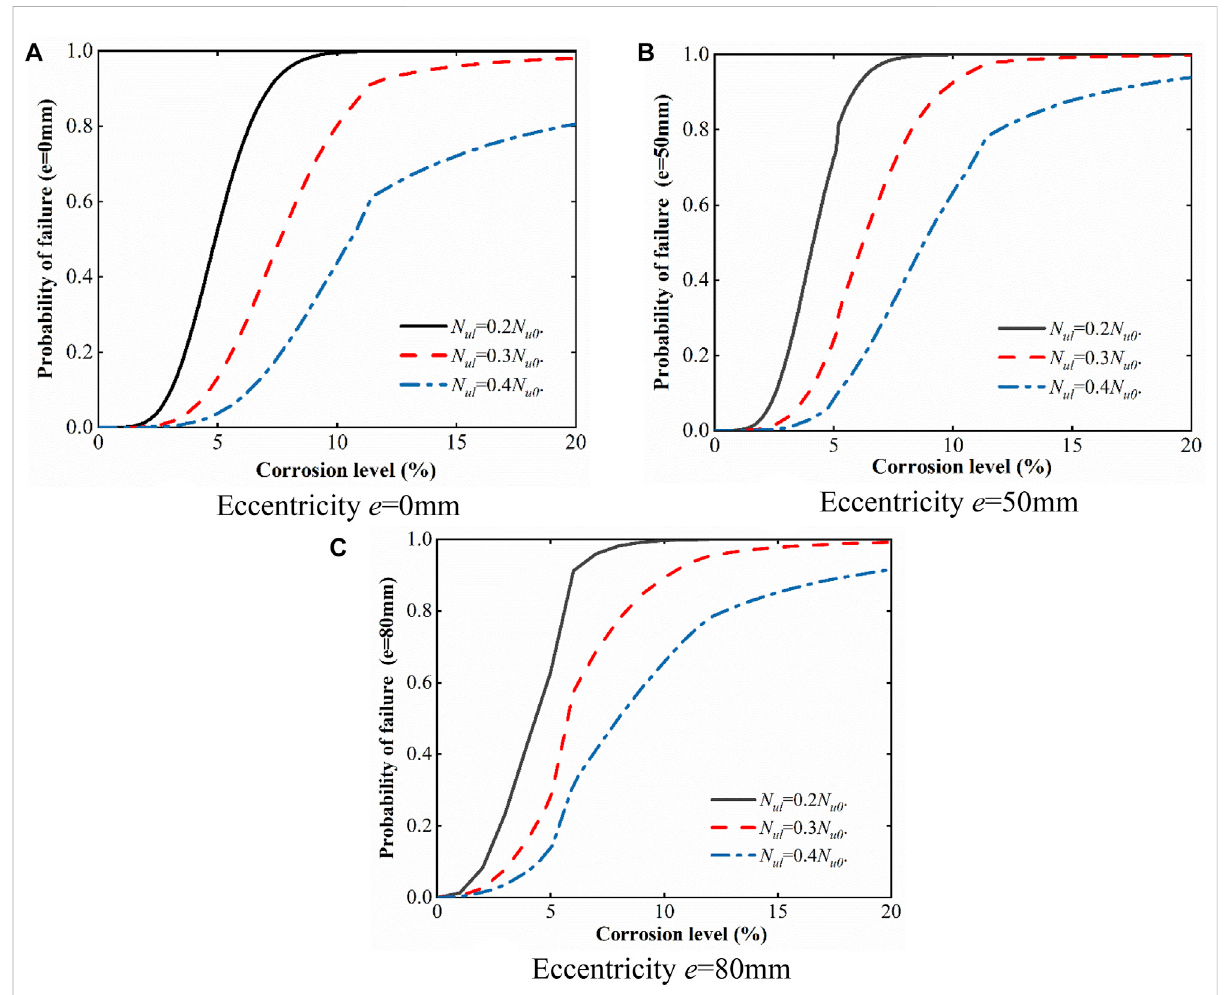
FIGURE 12 Predicted failure probability of the corroded RC columns under different loading conditions for various allowable deterioration limits N ul